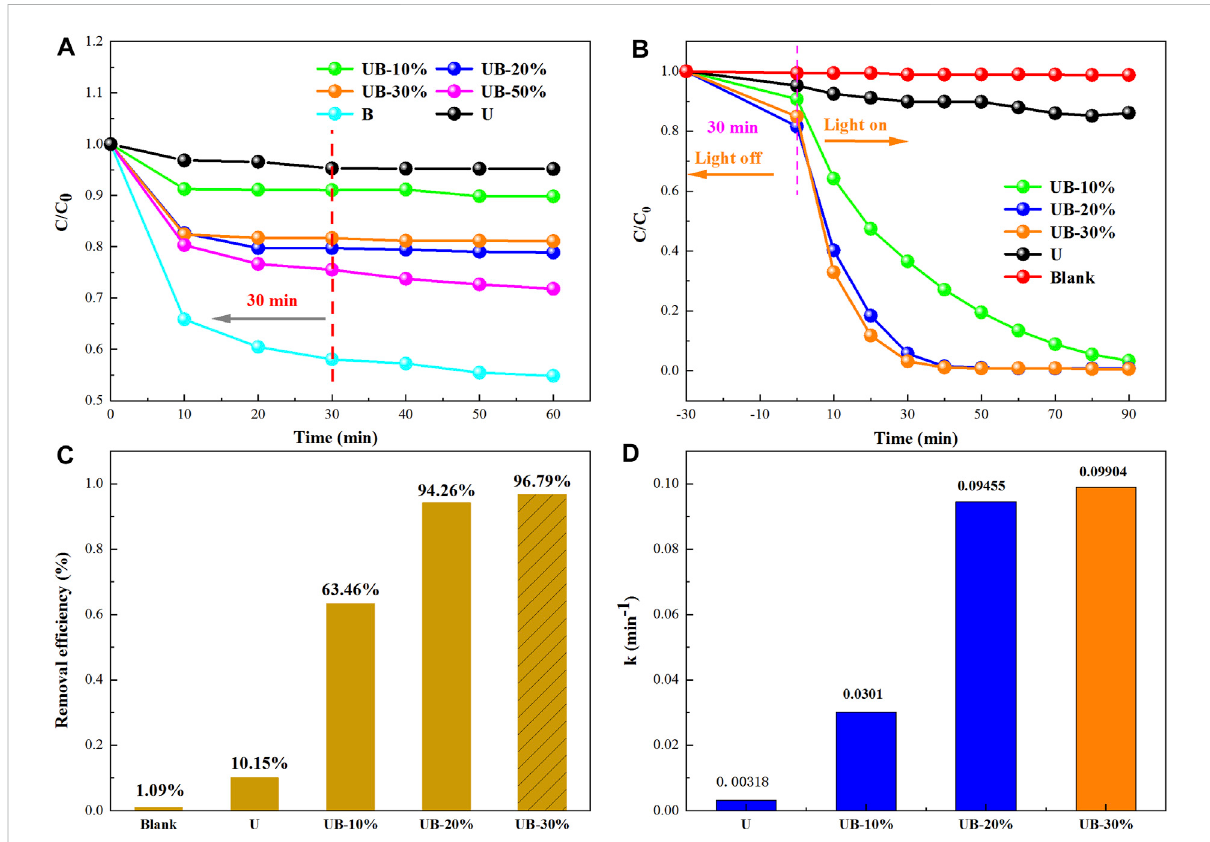
FIGURE 6 (A) darkadsorptionofRhB; (B) photocatalyticdegradationofRhBoveras-preparedphotocatalystsundervisiblelightirradiation; (C)